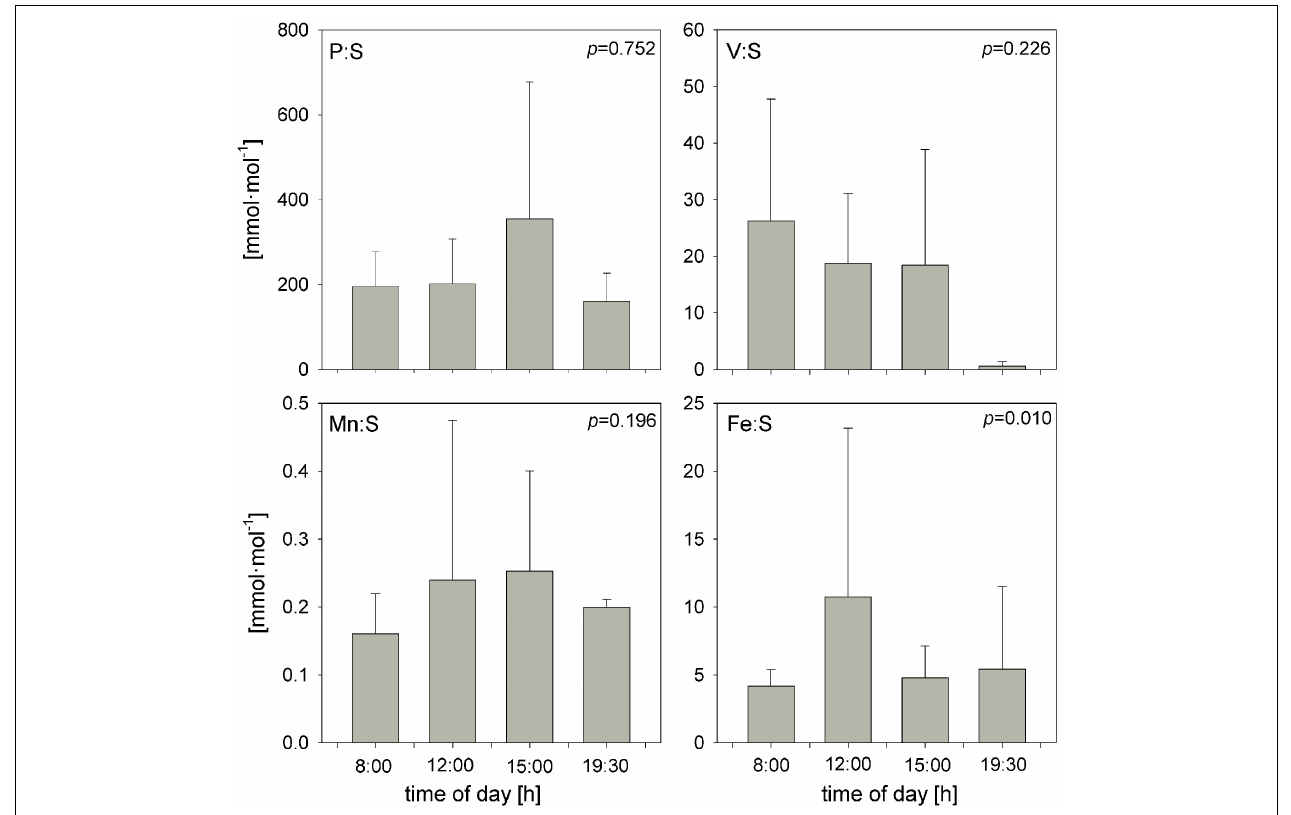
FIGURE 8 |Temporal comparison of S-normalized element stoichiometries determined with SXRF (combined oxalate and non-oxalate data from both beamlines) on individual trichome sections.